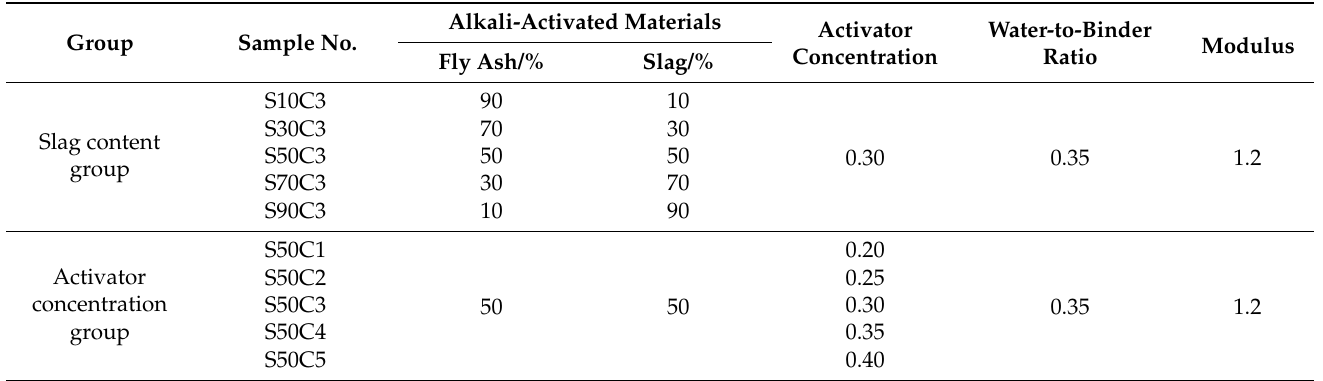
Table 2. Mixed-ratio alkali-activated fly ash–slag composite cementitious material.